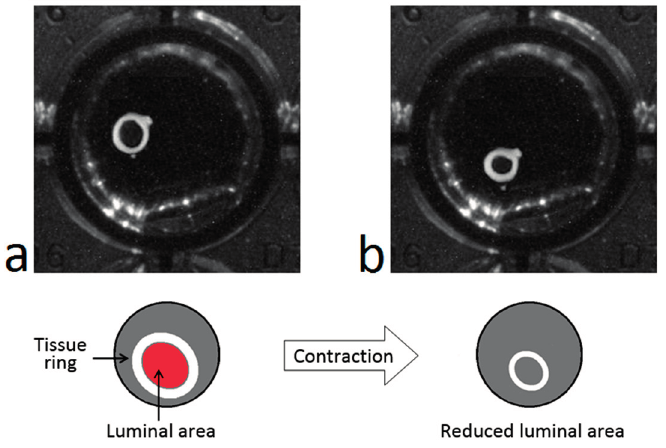
Figure 1. Representation of the contractile response: Rat aorta ring before ( a ) and after ( b ) the application of a contractile